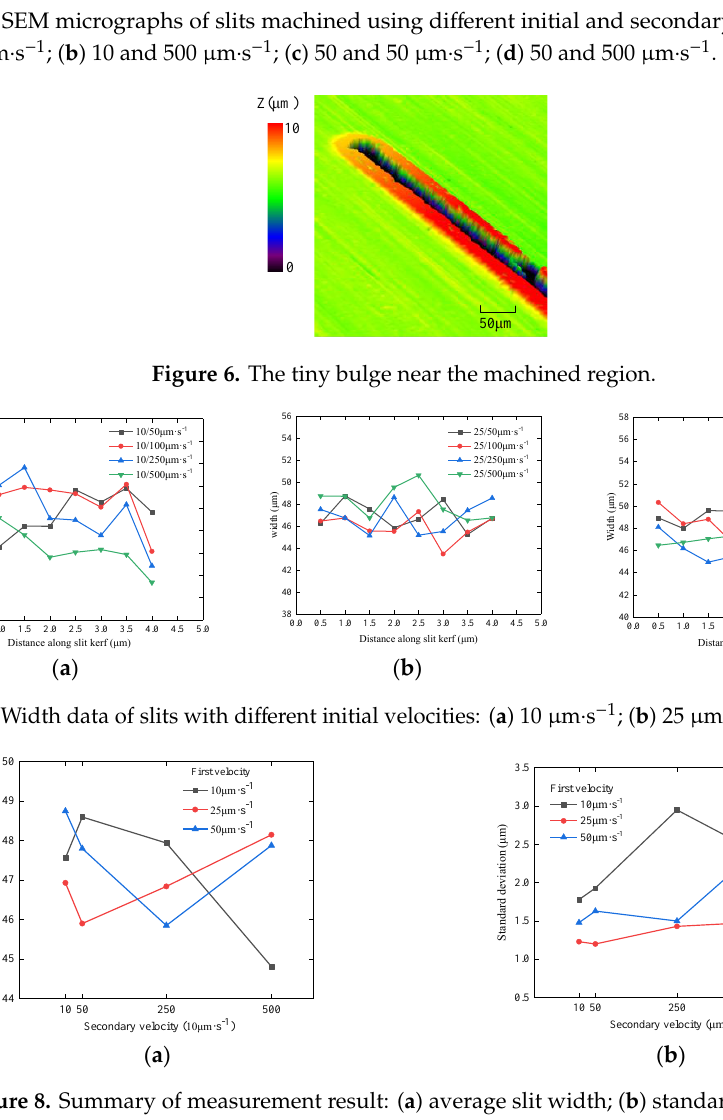
( b ) Figure 8. Summary of measurement result: ( a ) average slit width; ( b ) standard deviation. 4.2. Surface Roughness For each slit, 5 areas on its sidewall were randomly selected to measure surface roughness. Figure 9 shows the 3D views of some slit side walls machined under different velocities. The average roughness is summarized in Figure 10.